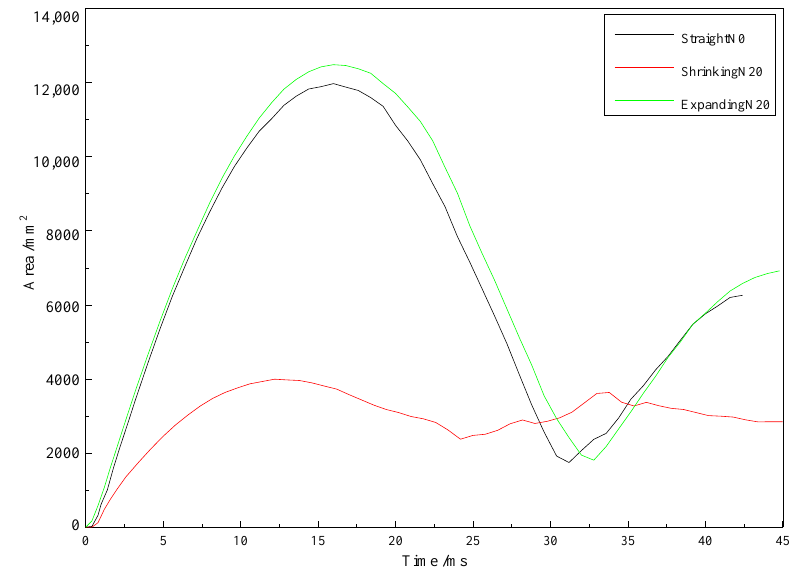
Figure 11. Curves of the area of the bubble projected when different nozzles were installed. Table 2. Characteristic parameters of the bubble pulsation when different nozzles were